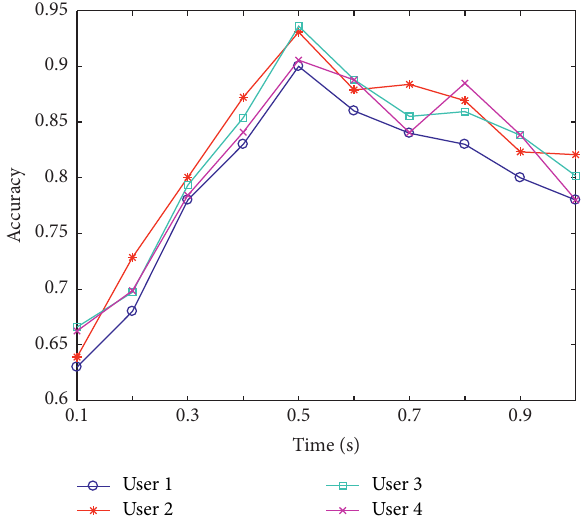
Figure 5: The structure of improved sequential pattern mining algorithm.